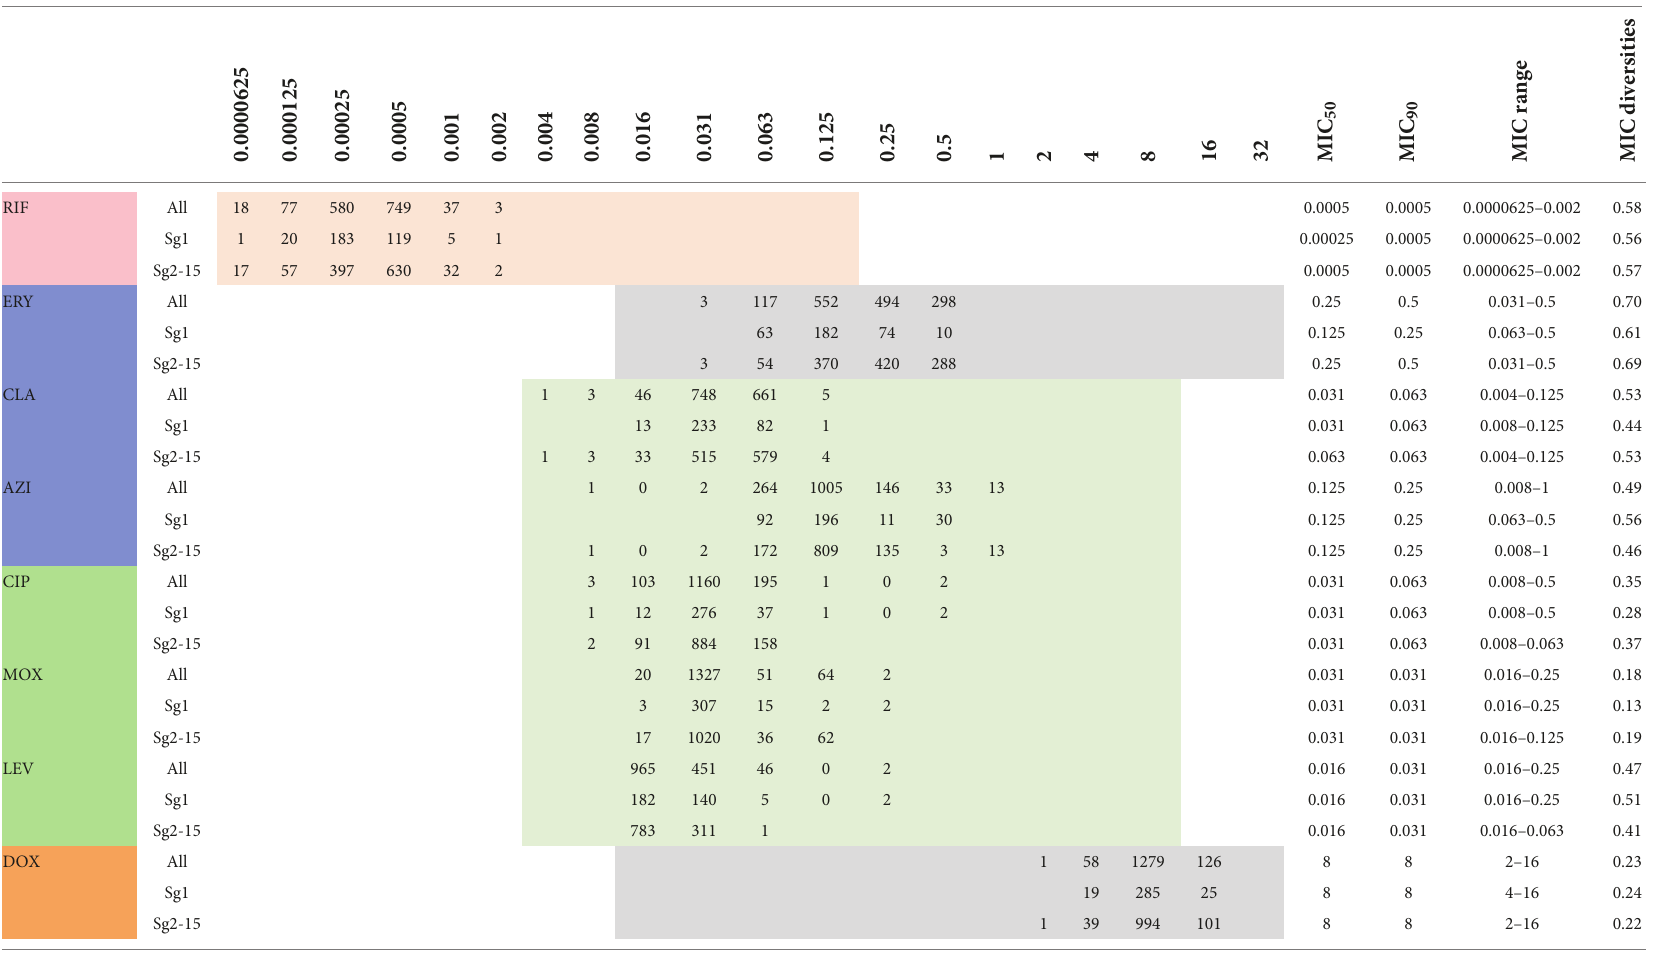
TABLE 1 Minimum inhibitory concentration (MIC) data of eight antimicrobials for the 1464 L. pneumophila isolates.